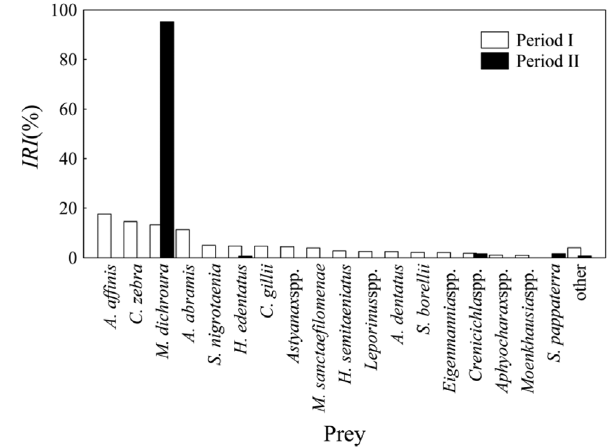
Fig. 4. Relative contribution (IRI) of prey fish in the diet of Acestrorhynchus pantaneiro in each sampling period at Manso Reservoir, Mato Grosso State, Brazil (n = 314; 187-period I and 127- period